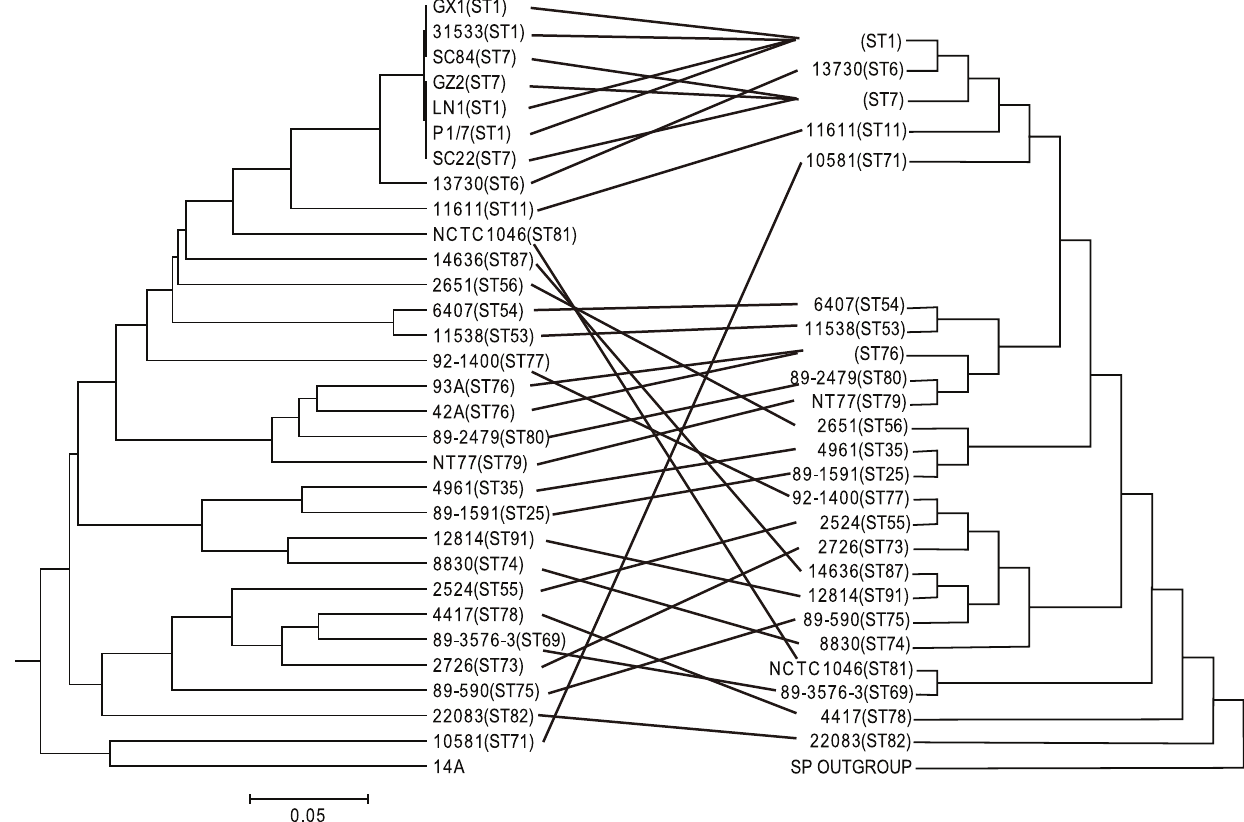
Figure 5. Comparison of phylogenetic relationships based on microarray data and multi-locus sequence typing (MLST) data. Dendrogram on the left was based on microarray data for the presence and absence of genes using UPGMA while phylogenic tree on the right in mirrored image was based on the concatenated sequences of 7 MLST alleles constructed using the neighbour joining method. The branches showing similar groupings were connected by lines. MLST based tree was rooted using a Streptococcus pneumonia strain marked as SP as an outgroup. Microarray data based tree was unrooted.